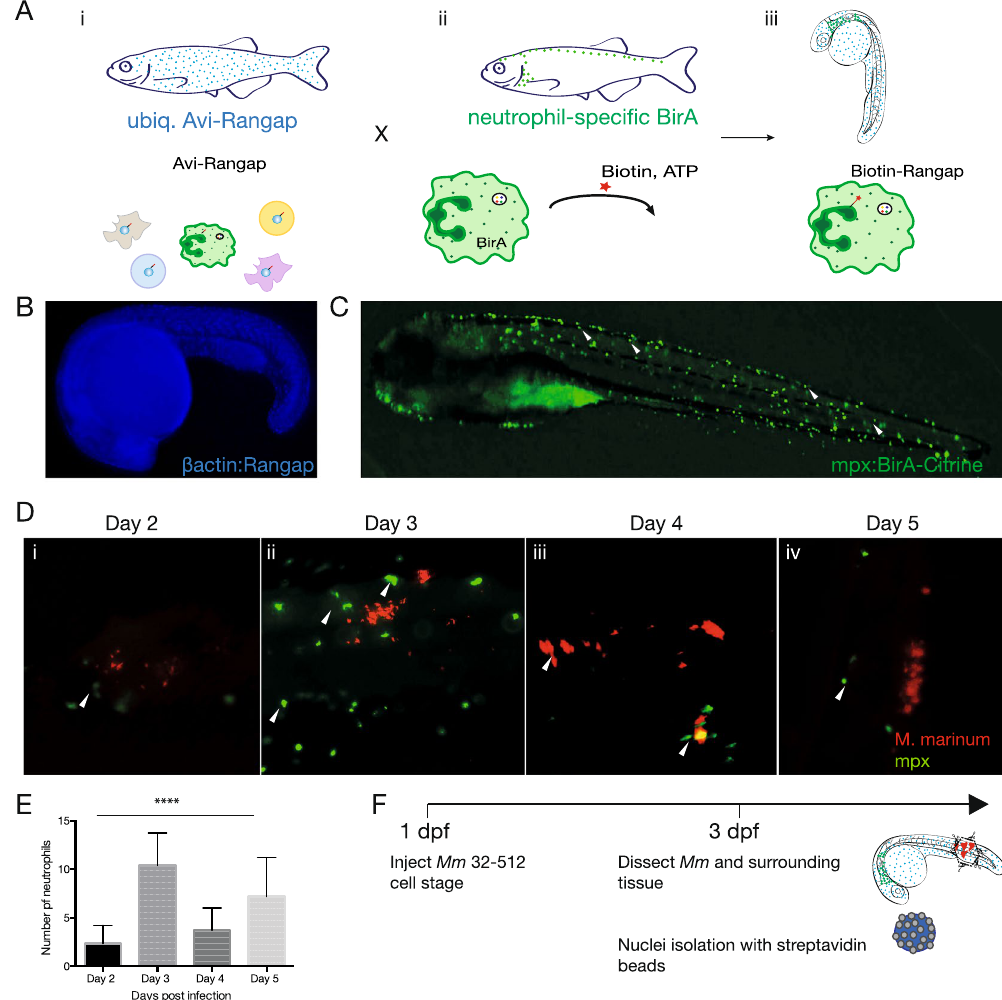
Figure 1. Binary transgenic zebrafish model for regulatory profiling of neutrophils in response to M . marinum . ( A ) Driver line expressing BirA in neutrophils (i) is crossed with effector line ubiquitously expressing Avi- tagged Rangap (ii) for biotinylation of nuclei. In double transgenic fish, only the nuclei of neutrophils will be biotinylated (iii). ( B ) Effector line with ubiquitously expressed Avi-Cerulean-Rangap. ( C ) Neutrophil-specific BirA driver line with Citrine reporter. ( D ) Time course analysis of neutrophil infiltration of M . marinum . Embryos were injected with M . marinum at the 32-512-cell stage, fixed and immunofluorescence carried out for mpx protein at 2 dpi (i), 3 dpi (ii), 4 dpi (iii) and 5 dpi (iv). Neutrophil localisation is indicated by white arrows. ( E ) Neutrophil numbers in proximity to M . marinum were quantified at 2–5 dpi. Statistical significance was determined by one way ANOVA (n = 14–18, **** p < 0 . 0001 ). ( F ) Infection model for subsequent